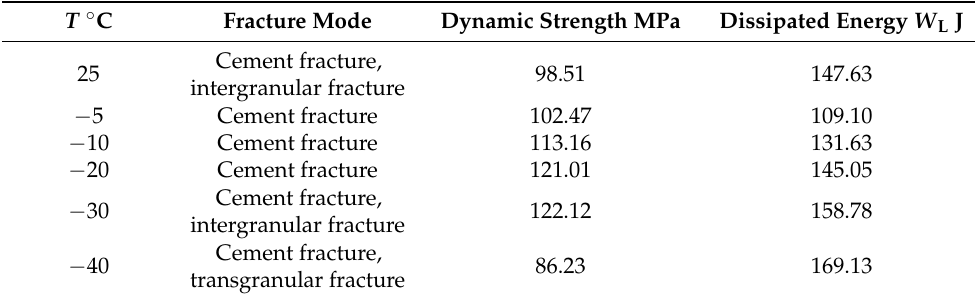
Table 4. Fracture model vs. dissipated energy.